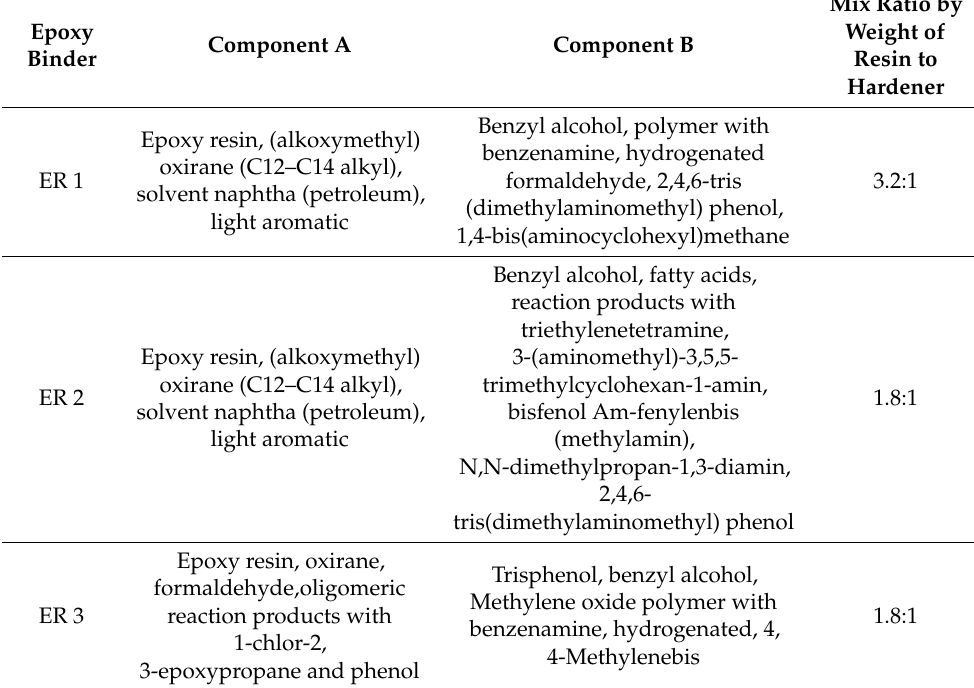
Table 1. Polymer binder types used—basic bases, hardener type used and mixing ratio.